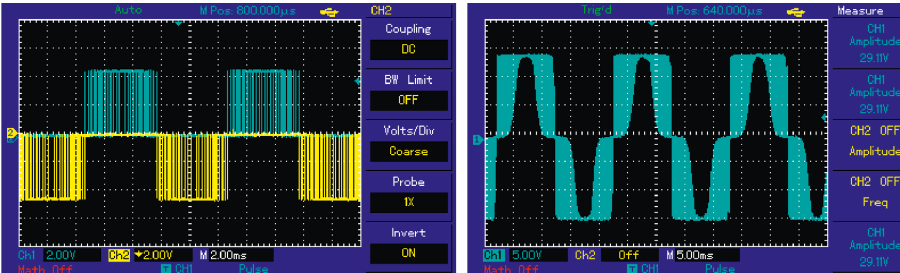
Figure 14: The generated waves from the Arduino